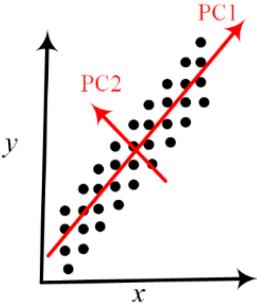
Figure 1. A schematic representation of principal component analysis. The data points contained in the dataset characterized by the original coordinate variables x and y are more distinguishable by their projections onto the PC1 direction than either x or y directions. The projections onto PC1 contain the largest variance, which suggests that the two-dimensional x – y space may be reduced to the one-dimensional PC1 space.